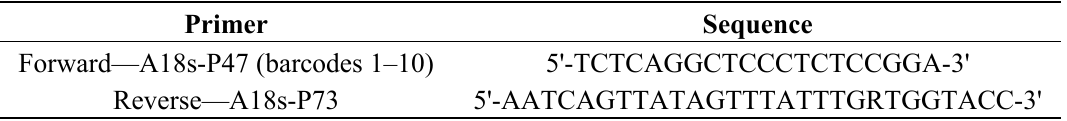
Table 2. Forward and reverse primers applied for 18S RNA gene sequencing in metagenomics analysis of the samples collected from the WSPs.